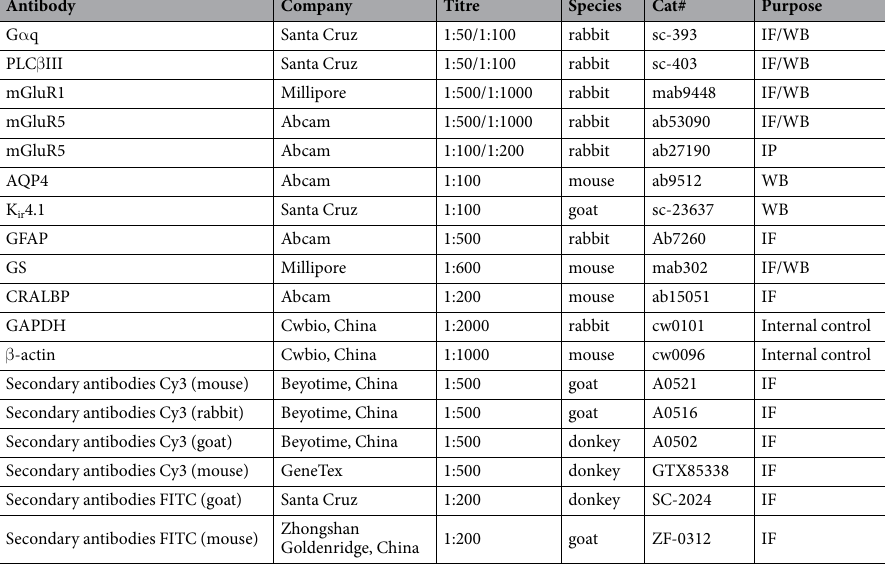
Table 1. Antibodies used in immunofluorescence staining, western blotting and immunoprecipitation.